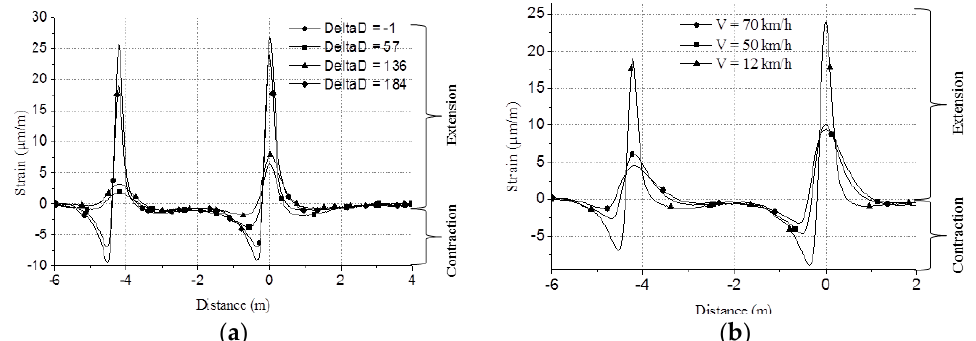
Figure 12. Instrumentation of the A41N highway in France. ( a ) Longitudinal strain in the subbase course for different truck trajectories (V=12 km/h, T=20 °C) and ( b ) longitudinal strain in the subbase for different speed (same trajectory, T=23 °C) (figures are reproduced from Gaborit et al. [41]).